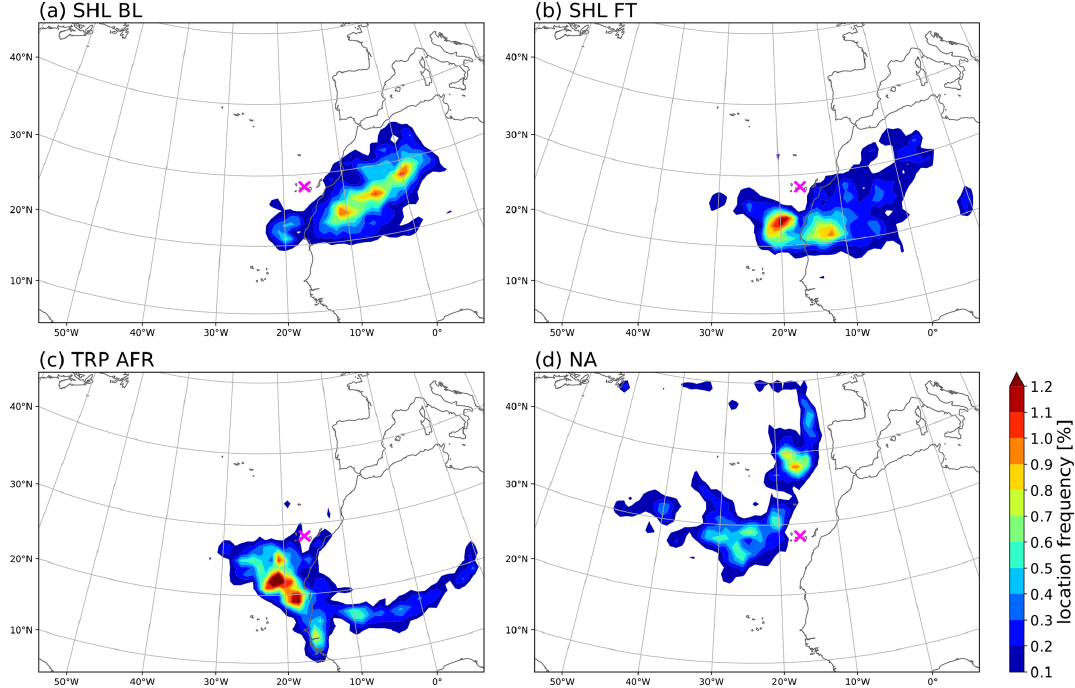
Figure 12. Gridded location frequency of COSMO iso backward trajectories 3d prior to arrival at 500–700hPa above Tenerife (magenta cross) classified into groups with different transport pathways. (a) Air parcels originating from the boundary layer of the Saharan heat low (SHL BL, 32% occurrence frequency), (b) air parcels originating from the free troposphere above the Saharan heat low (SHL FT, 26%), (c) air parcels coming from tropical Africa (TRP AFR, 16%), and (d) air parcels originating from the North Atlantic (NA, 26%).